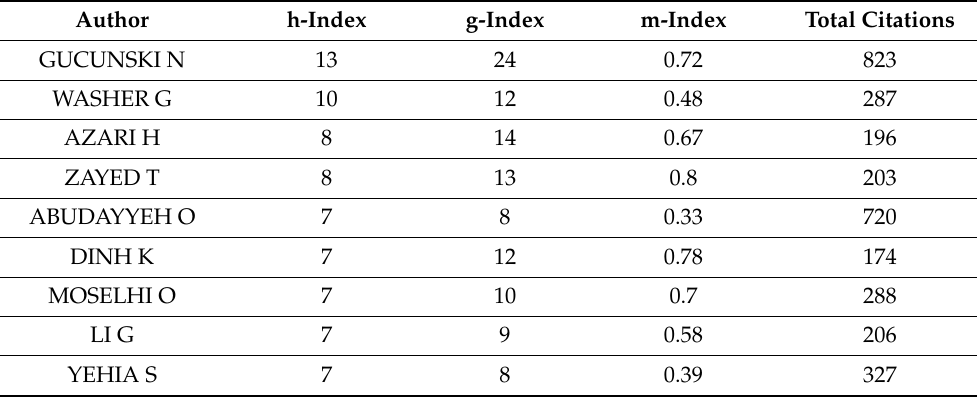
Table 7. Most influential authors in CBD_NDT